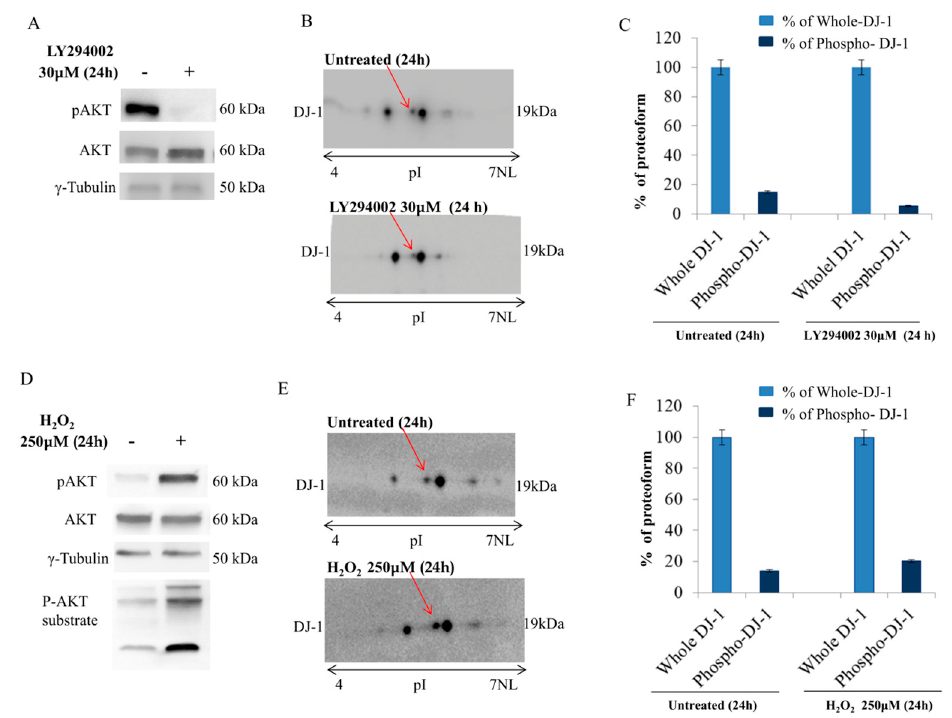
Figure 3. DJ-1 proteoforms analysis in MCF7 breast cancer cells ( A )Treatment of MCF7 cells with LY294002 (30 µ M for 24 h) induces the inhibition of pAkt. Total Akt and γ -tubulin were used as loading control; ( B ) 2D Western blot showing all DJ-1 proteoforms in whole cell extract during LY294002 treatment. LY294002 treatment induces a significant shift of DJ-1 proteoforms (red arrow) toward basic pH according to the loss of acidic proteoforms ( B ); ( C ) Densitometric analysis of DJ-1 proteoform modulated by LY294002 treatment; ( D ) In MCF7 breast cancer cells, mild oxidative stress (H 2 O 2 250 µ M for 24 h) increases the phosphorylation of Akt together with the phosphorylation of Akt substrates. Total Akt and γ -tubulin were used as loading control; ( E ) 2D Western blot showing all DJ-1 proteoforms in whole cell extract during H 2 O 2 treatment. During the activation of Akt pathway, it is possible to observe in DJ-1 proteoforms (red arrow) a shift toward acid pH. The shift is coherent with the